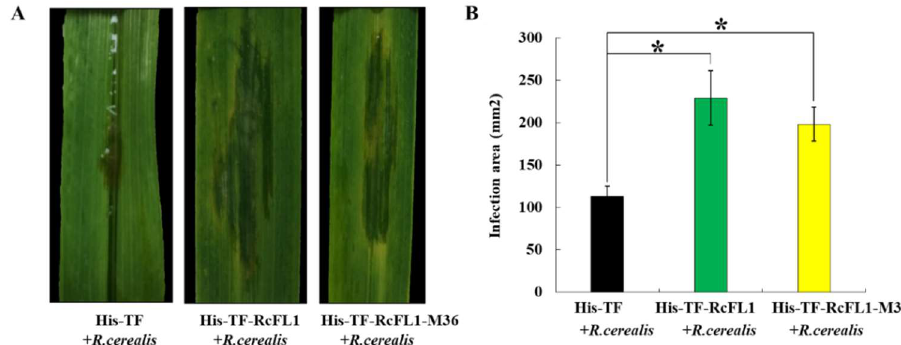
Figure 6. RcFL1 protein and its MEP36 domain-containing peptide contribute to virulence of R. cerealis . ( A ) His-TF-RcFL1 and His-TF-RcFL1-MEP36 enhanced infection area of R. cerealis in wheat leaves. Heterologously-expressed protein, His-TF-RcFL1, His-TF-RcFL1-MEP36, or His-TF; each was infiltrated in 25 µL (concentration 5 µM/L). Pictures of the lesions were taken at three days post inoculation with the fungus and the lesion area was measured; ( B ) the lesion area/infection was measured after R. cerealis Rc207 liquid mycelia inoculation for three days on leaves infiltrated with heterologously-expressed RcFL1, RcFL1-MEP36 in 25 µL (concentration 5 µM/L). Six leaves were used in each experiment and repeated three times. Asterisk * indicates significant difference between His-TF-RcFL1 or His-TF-RcFL1-MEP36 treatment and His-TF treatment ( t -tests, p < 0.05).